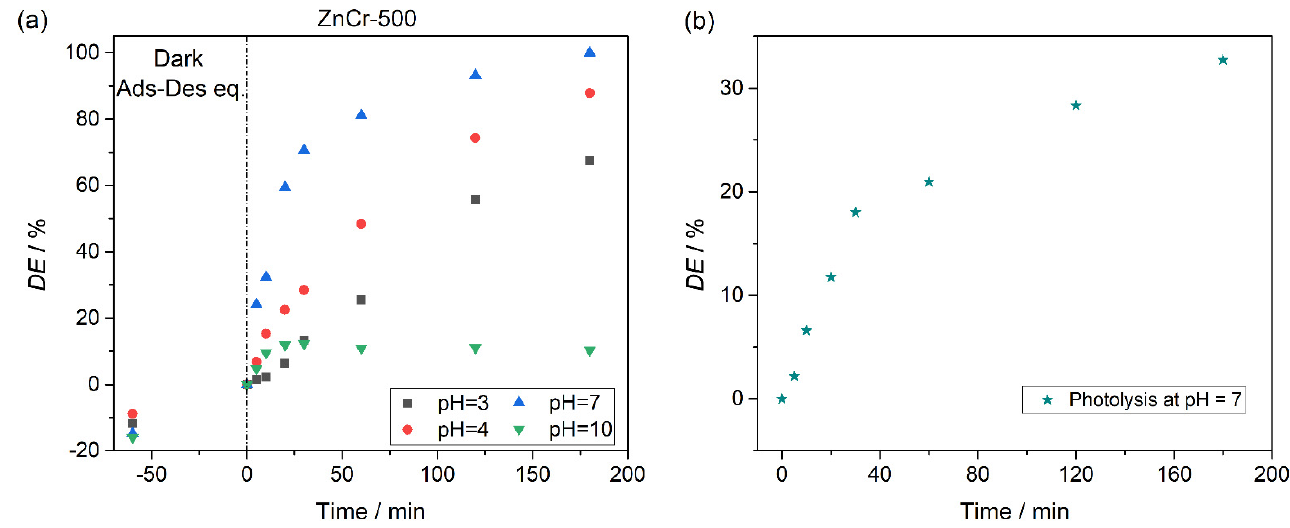
Figure 10. ( a ) Photocatalysis degradation of CV dye according to pH using ZnCr-500 material as photocatalyst. ( b ) Photolysis test at pH = 7.